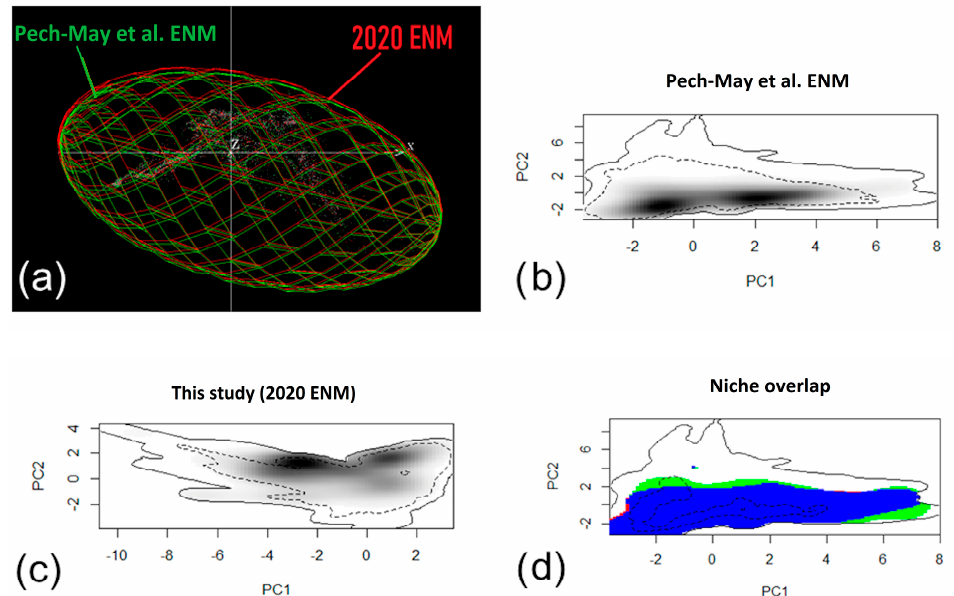
Figure 4. Niche overlap between the Pech-May et al. [9] ecological niche model (ENM) and the 2020 ENM of Aedes albopictus in México. ( a ) The ecological niche model is based on a minimum-volume ellipsoid in NicheA. ( b ) Occupied niche based on the Pech-May et al. [9] ENM. ( c ) Occupied niche based on the 2020 ENM. ( d ) Niche overlap of both ecological niches: blue depicts the niche overlap, red depicts the Pech-May et al. [9] ENM, and the green depicts the 2020 ENM.